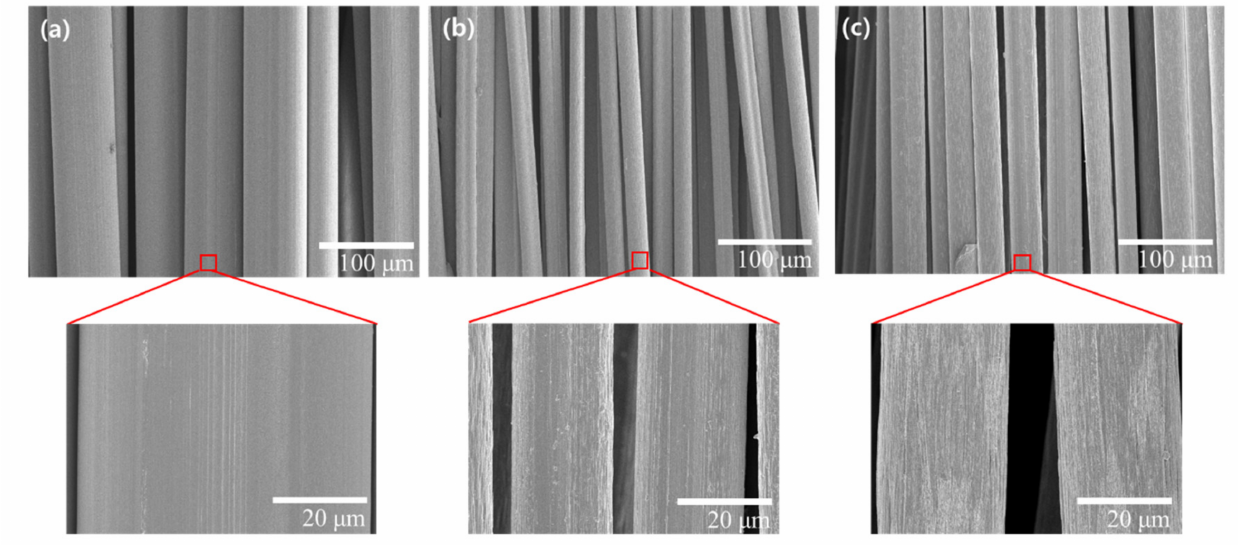
Figure 4. Scanning electron microscopy (SEM) images for surface structure of wet-spun fibers. ( a ) as-spun, ( b ) dry drawing, and ( c ) wet